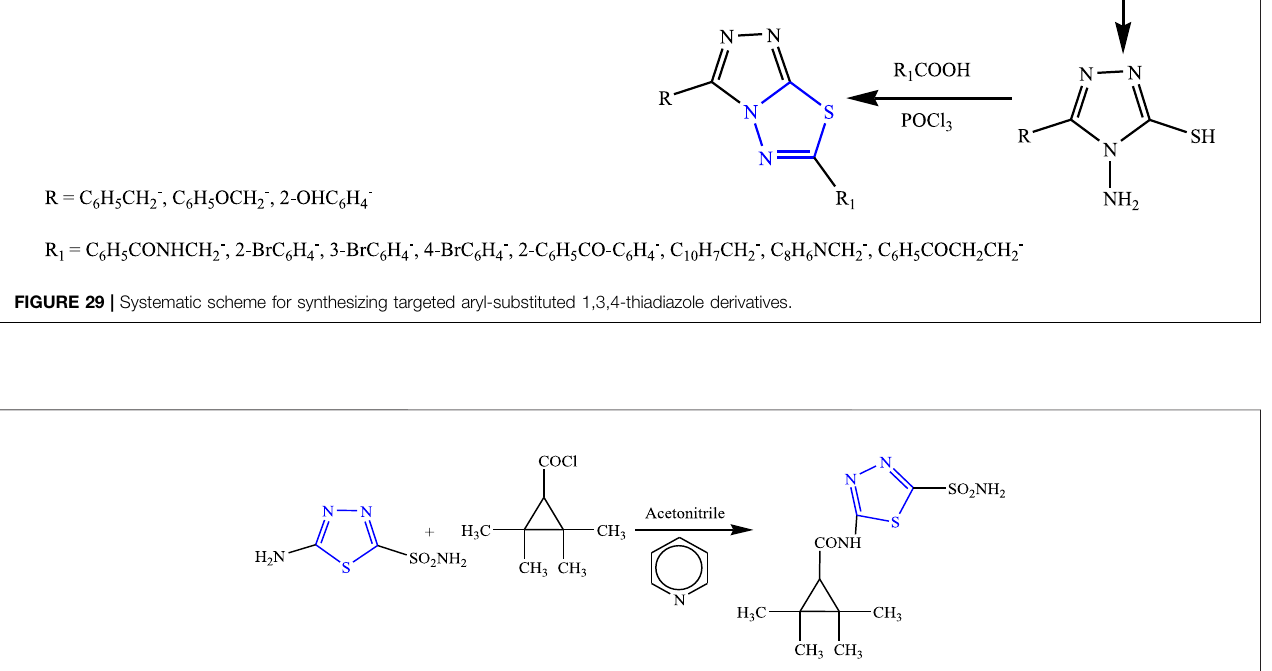
Frontiers in Chemistry |